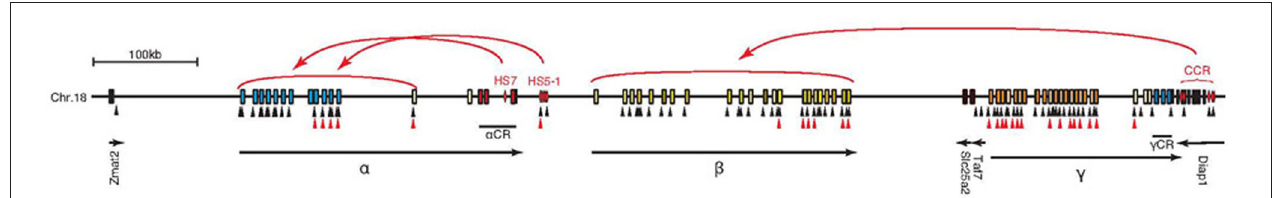
located downstream from the Pcdh- γ cluster. The control elements for the Pcdh- γ cluster have not been identified yet. Several CTCF-binding and cohesin-SA1-binding sites exist in the large clustered Pcdh gene cluster locus. Black and red triangles indicate CTCF-binding and cohesin-SA1-binding sites,